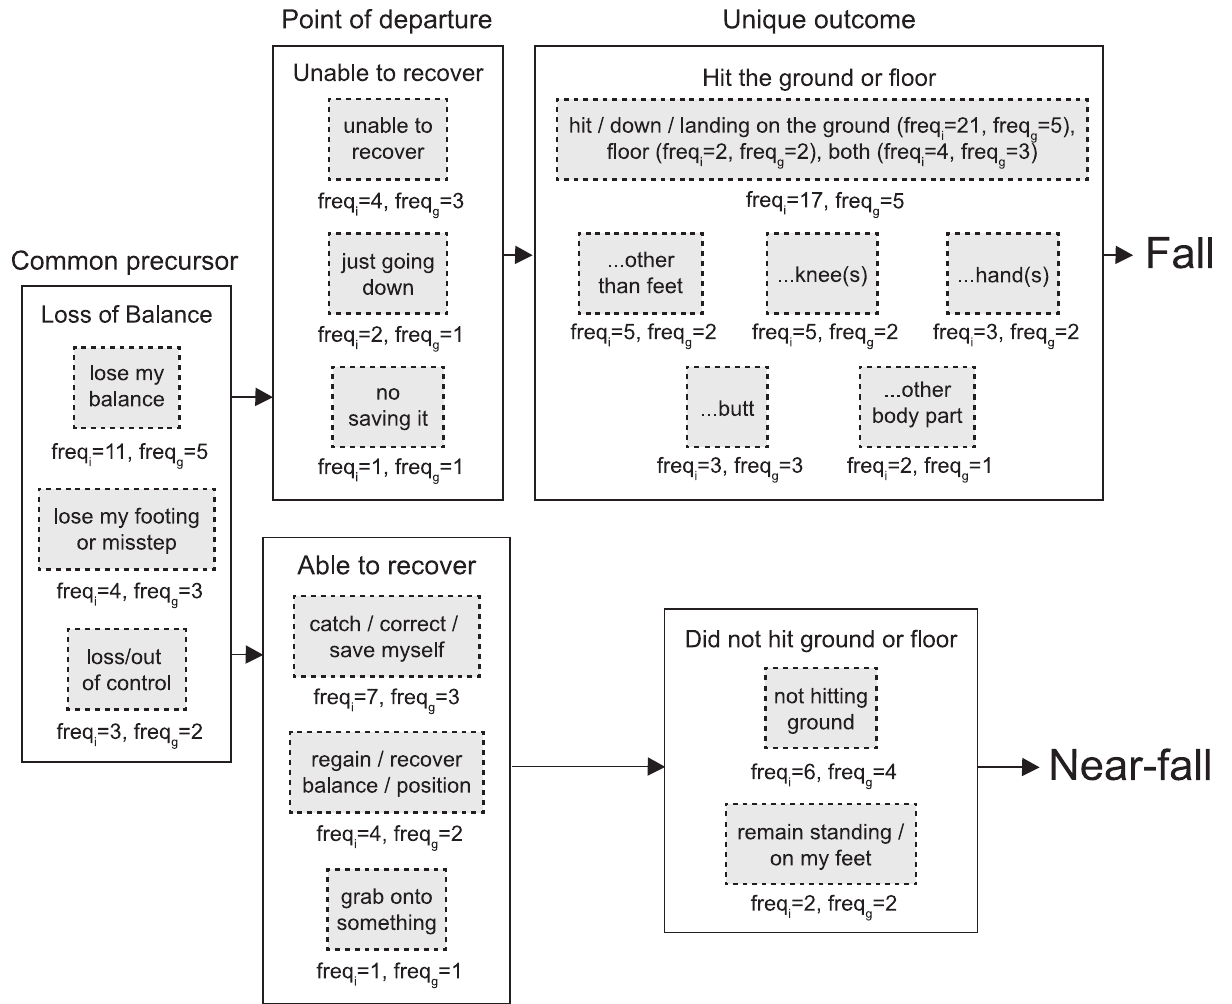
Fig 1. Formulation of the fall event definitions. Definitions for two overlapping yet unique fall events were proposed, tested, revised, and ultimately understood by lower limb prosthesis users. The focus group excerpts and the frequency with which they were used by the 25 individual lower limb prosthesis users (i.e., freq ) regardless of focus group, as well as across the five focus groups (i.e., freq i falls was a loss of balance. The ability or inability to recover marked the point of divergence between the two events, each ending in a unique outcome (i.e., hitting the ground / floor or